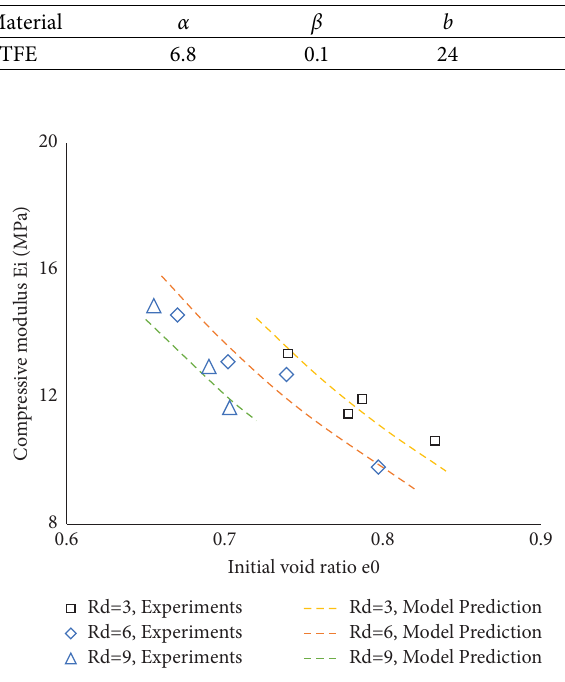
e curves vs. the experimental data i ∼ 0